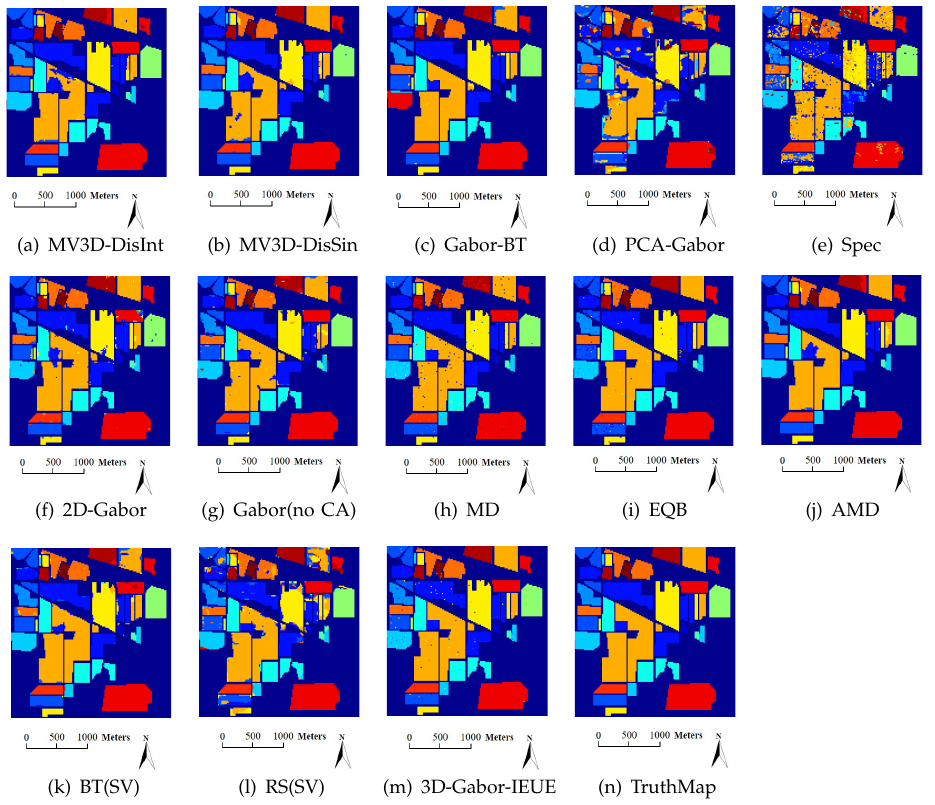
Figure 8. Classification maps of the Indian Pines data with a final of 320 training Figure 1. Classification maps of the Indian Pines data with a final of 320 training samples.